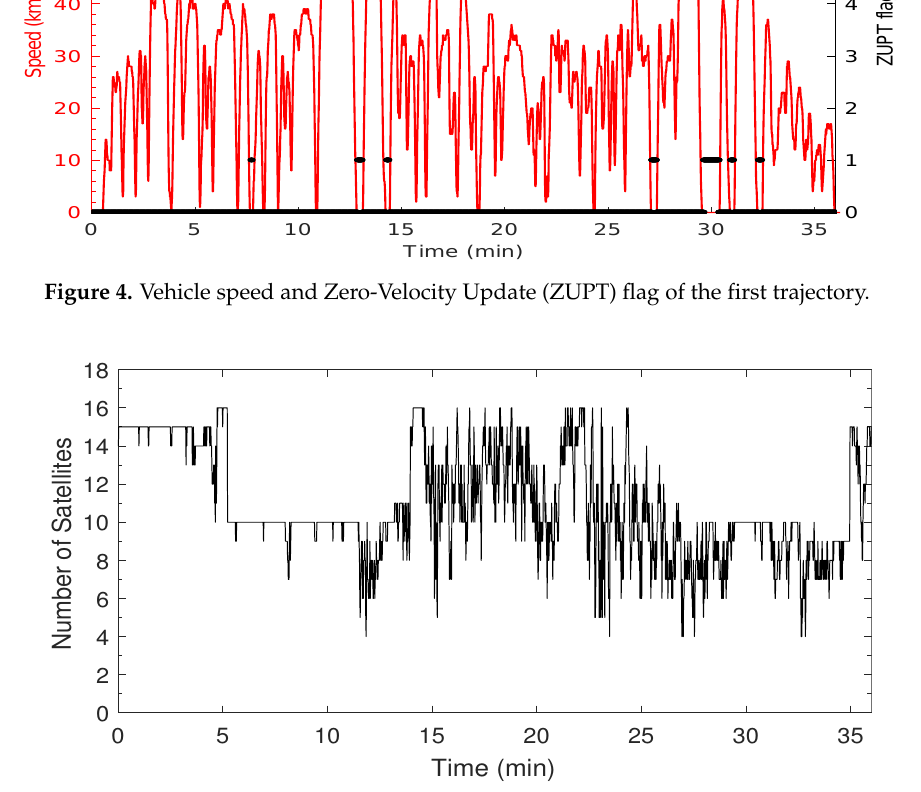
Figure 5. Number of satellites used in the PPP solution of the first